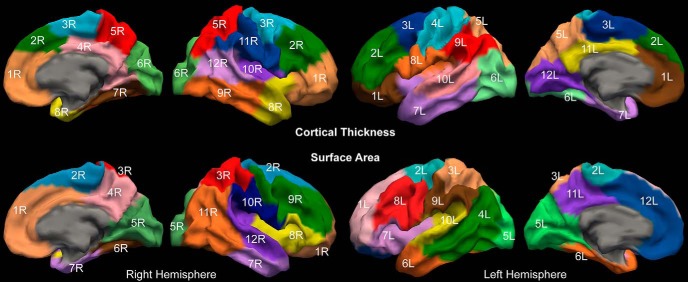
Summary of genetic parcellation of the CT and SA. Clusters are labeled 1L to 12L for the left hemisphere and 1R to 12R for the right one. Extended Data Figures 2-1, 2-2, 2-3, 2-4 describe the genetic clusters used in this analysis.